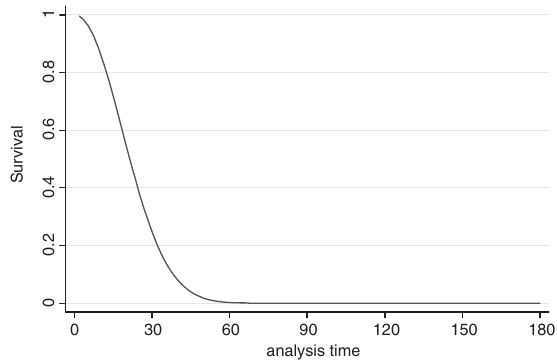
Fig. 6. The predicted survival curve of the home-to-work travel duration of Program C